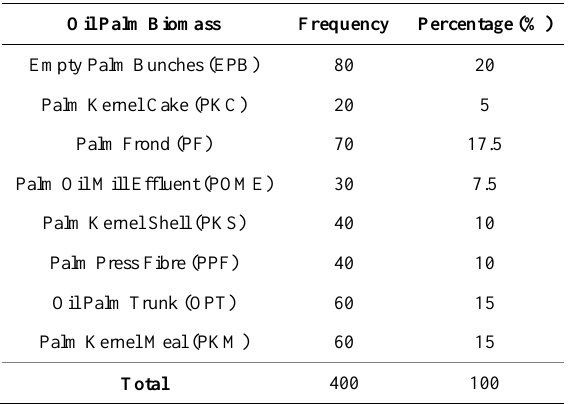
Table 1. Analysis of Respondents on the various Oil Palm